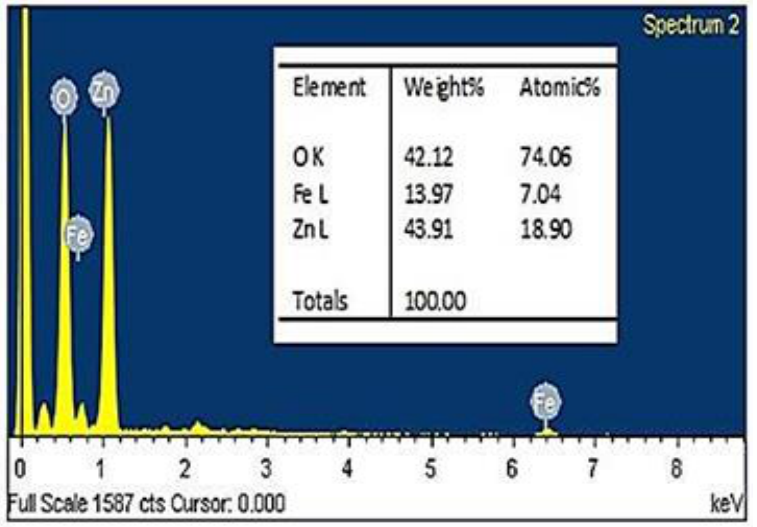
Figure 5. Energy-dispersive X-ray spectroscopy (EDS) pattern ZnFe 2 O 4 nanoparticles.